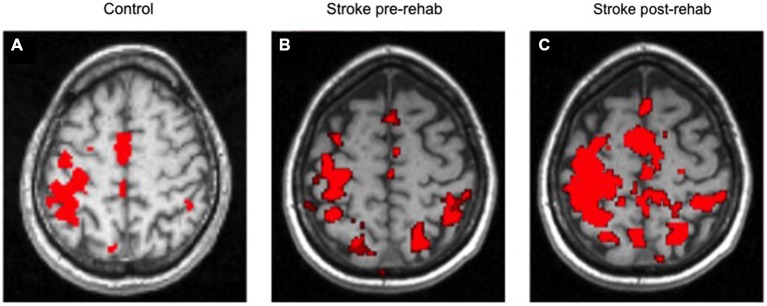
Average control brain activation map (A); Example of stroke at Pre- Treatment (B) and Post Treatment (C). Left side of each image is contralateral to the moving arm.